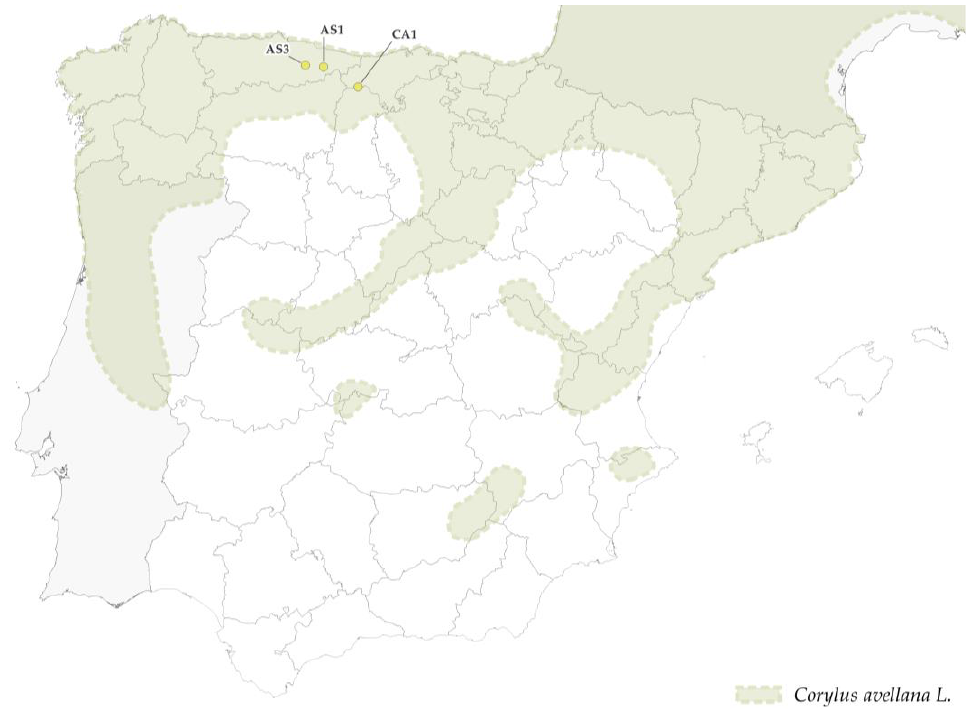
Figure 5. Distribution map for the species Corylus avellana L. and location of the cases identified as belonging to this species. Map drawn up by the authors using the information obtained from the database Chorological Data for the Main European Woody Species [42].